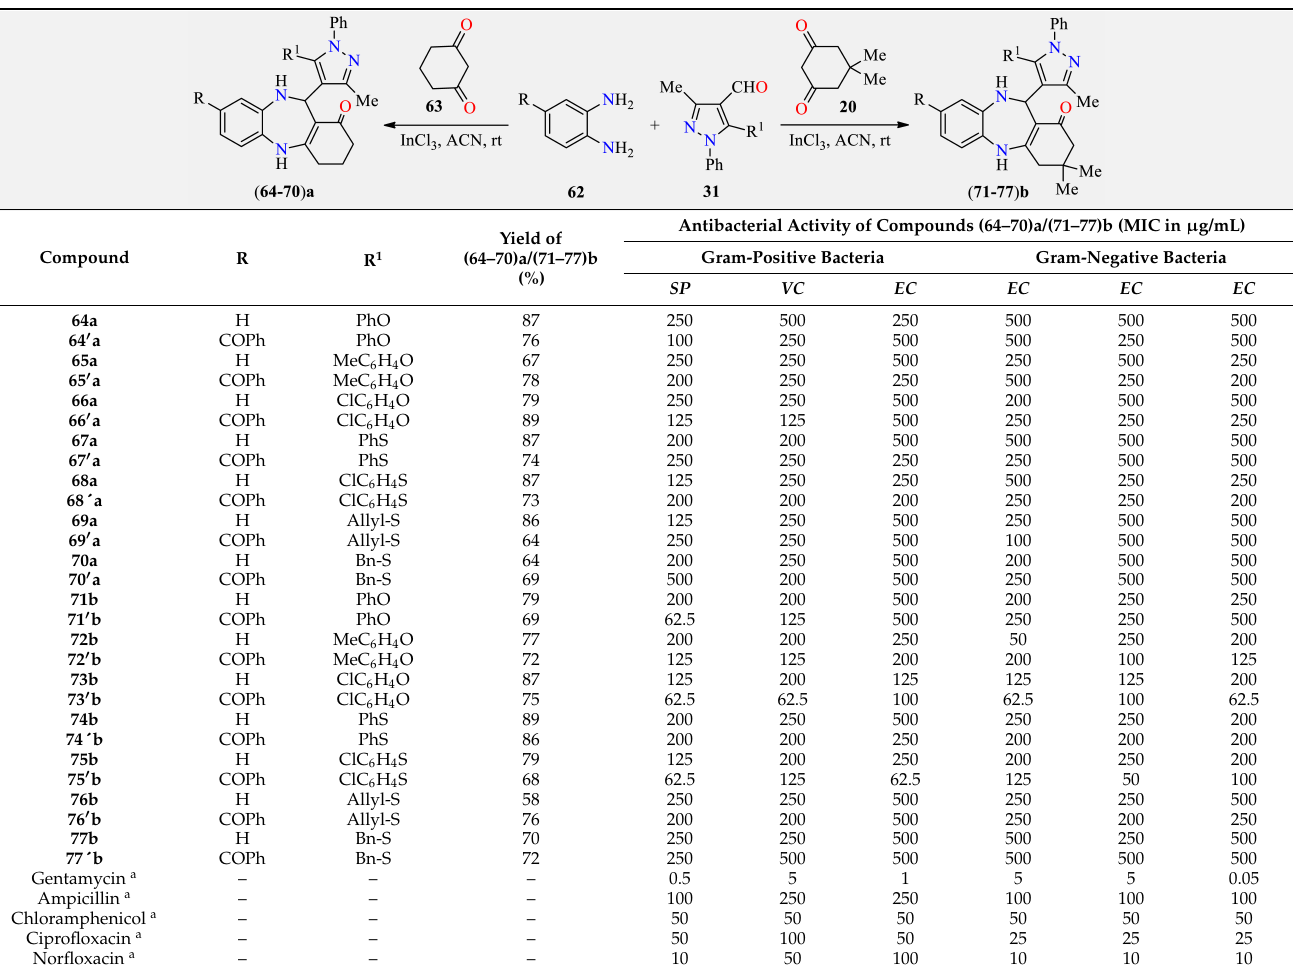
Table 18. Three-component synthesis of pyrazolo-diazepinones ( 64–70 ) a /( 71–77 ) b and their in vitro antibacterial activity (MIC) against six bacterial